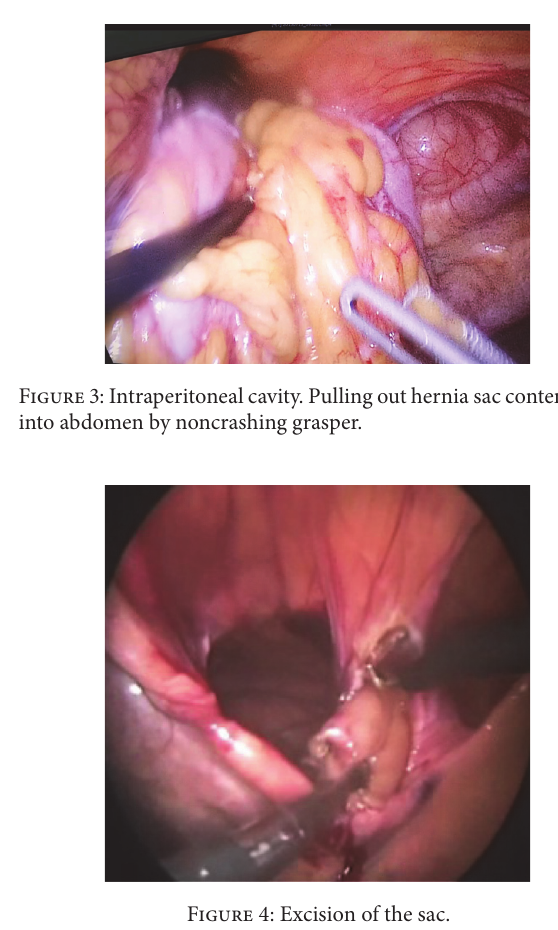
Figure 2: Chest X-ray. Mass with air-fluid level in right hemithorax.